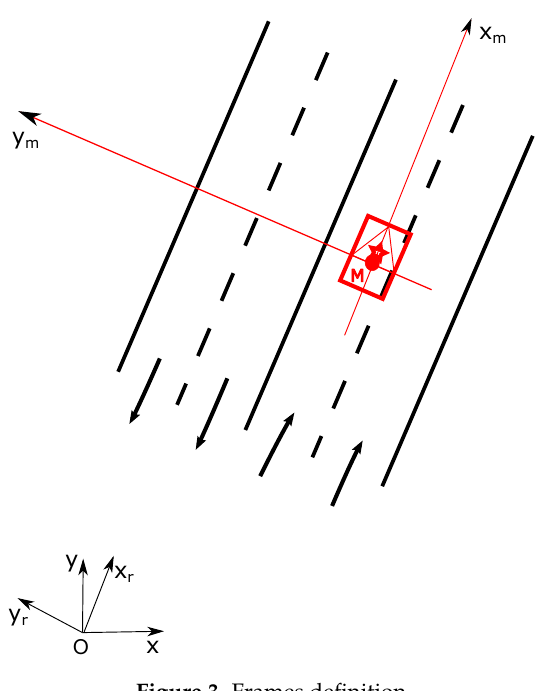
Figure 3. Frames